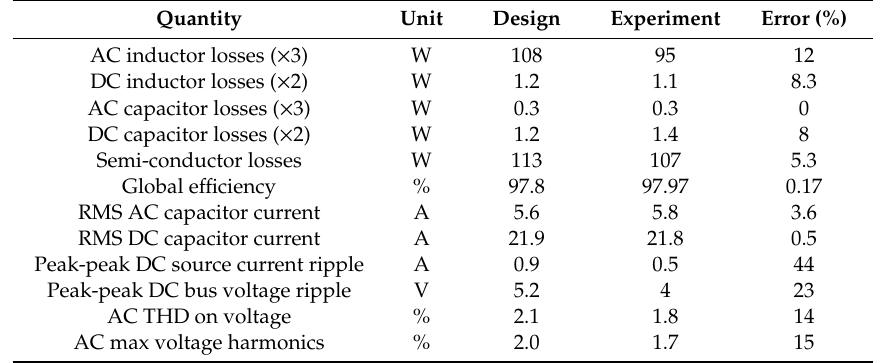
Table 6. Comparisons between optimization results and experiments for the empirical core